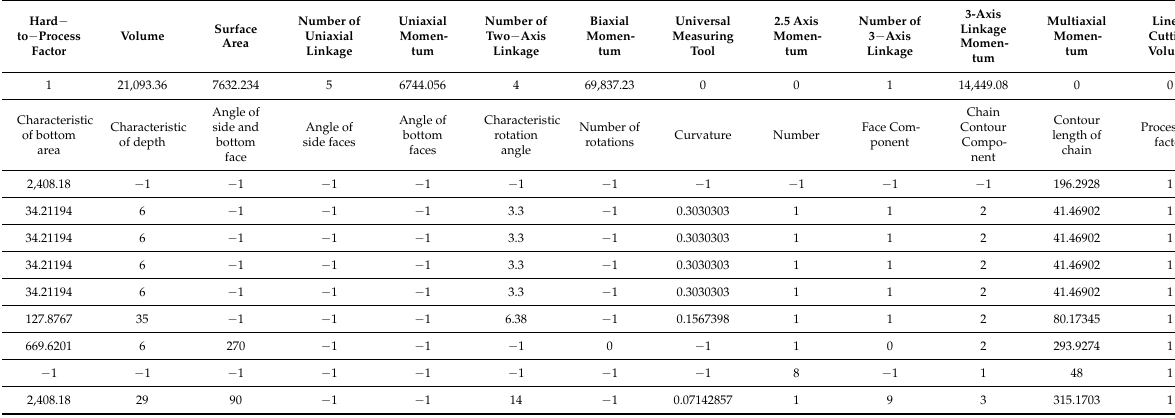
Table 6. Shows the results of the second half of the feature recognition and quantities in comma- separated value (CSV) file.